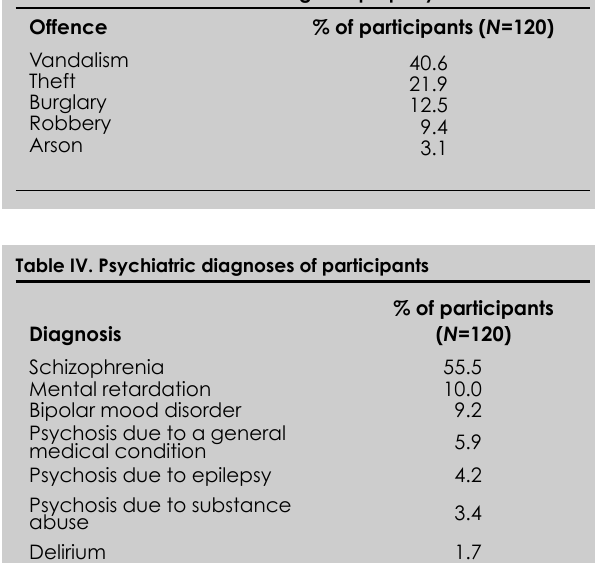
Characteristics